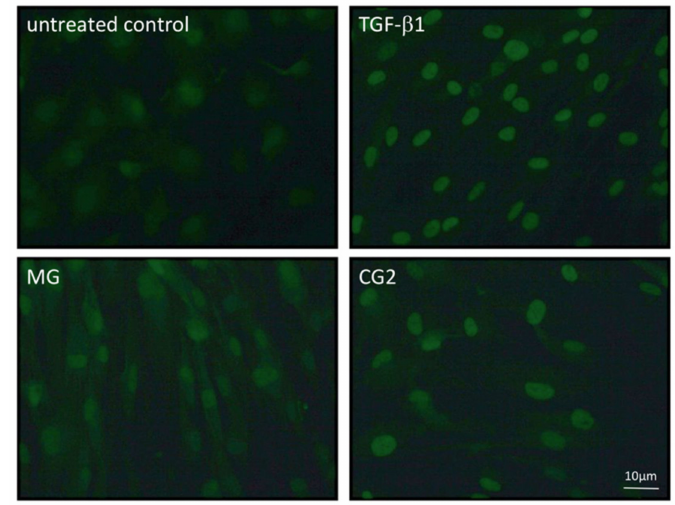
Figure 7. Smad2 / 3 nuclear translocation is induced by supernatants of MG and